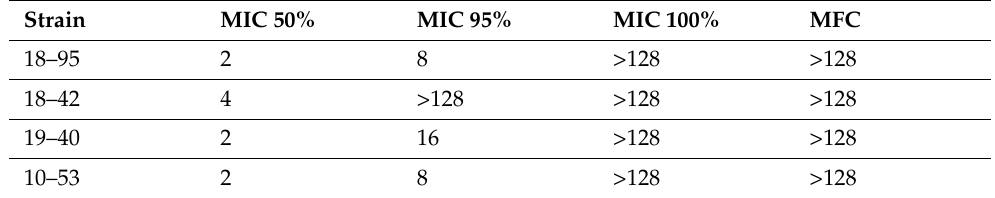
Table 2. Effects of NikZ on planktonic fungal growth at 48 h of incubation. Concentrations (µg/mL). The same results were obtained in two independent experiments.